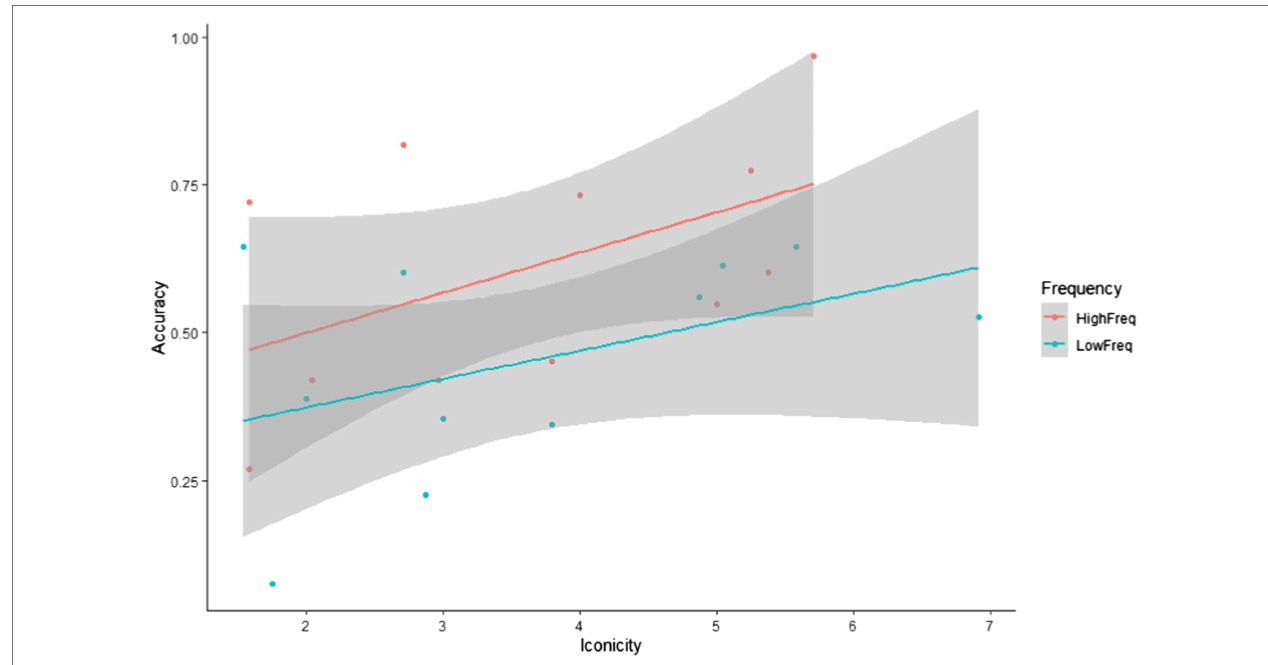
FIGURE 6 | Correlation between iconicity ratings and accuracy rates by frequency.